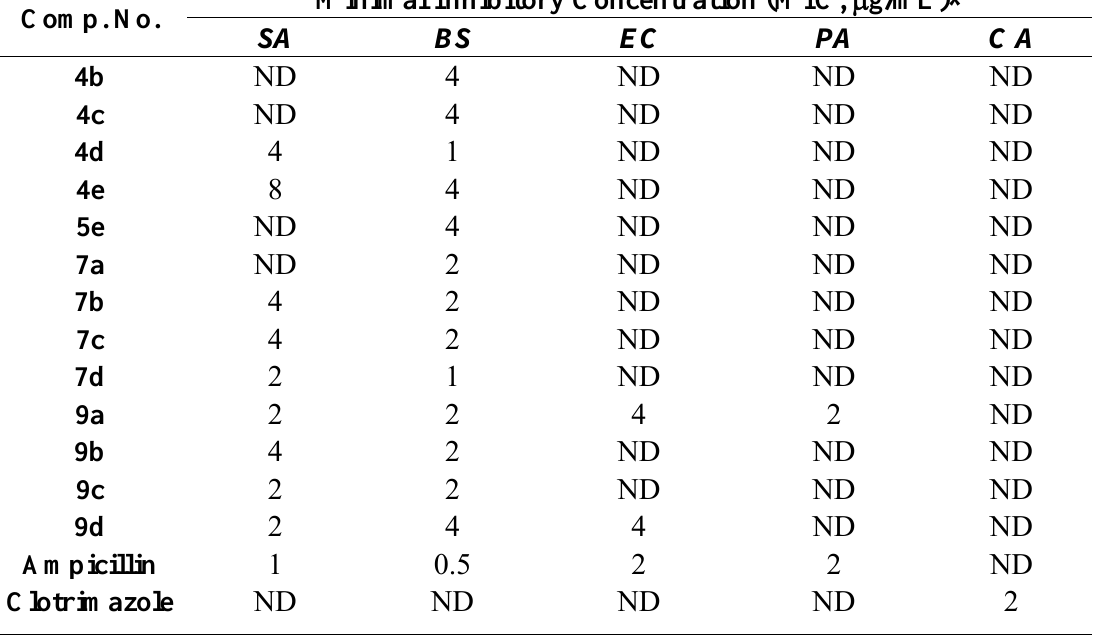
Table 3. The minimal inhibitory concentrations (MIC,  g/mL) of compounds 4b , 4c , 4d , 4e , 5e , 7a , 7b , 7c , 7d , 9a , 9b . 9c and 9d , the broad spectrum antibacterial drug Ampicillin and the antifungal drug Clotrimazole against Staphylococcus aureus IFO 3060 ( SA ), Bacillus subtilis IFO 3007 ( BS ), Escherichia coli IFO 3301 ( EC ), Pseudomonas aeuroginosa IFO 3448 ( PA ), and Candida albicans IFO 0583 ( CA ). Comp.